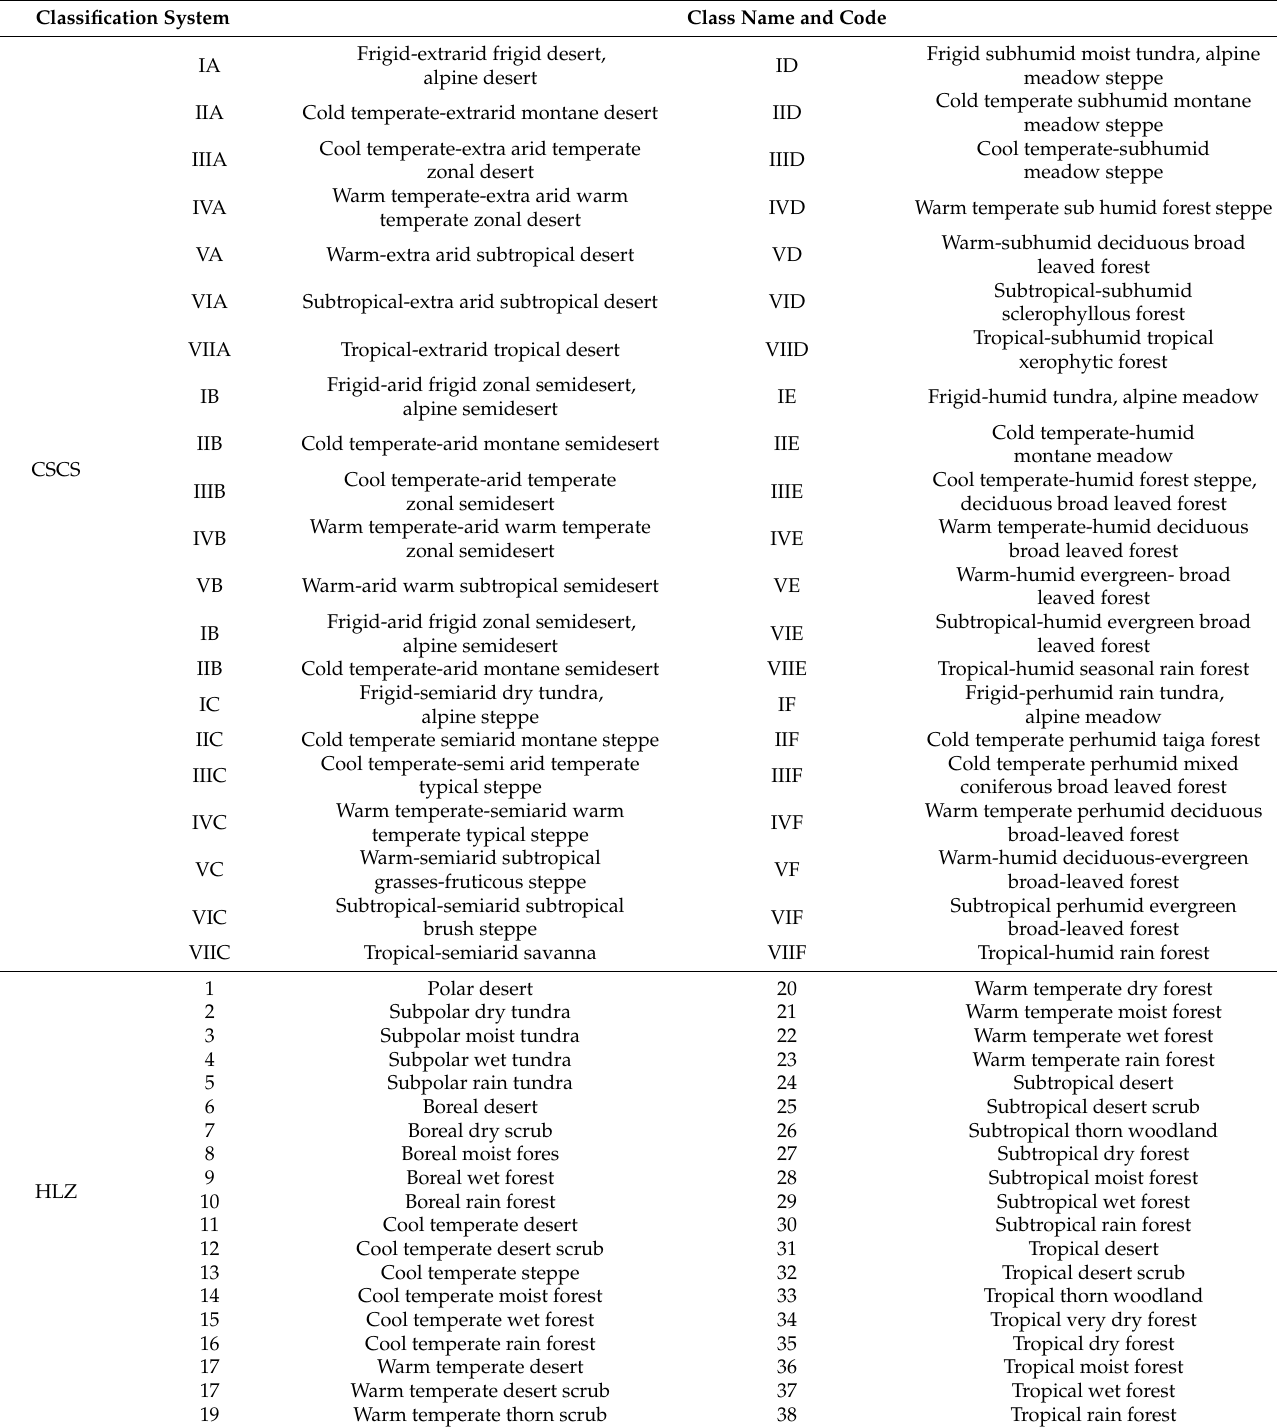
Table A1. The PNV classes for the CSCS model and the HLZ